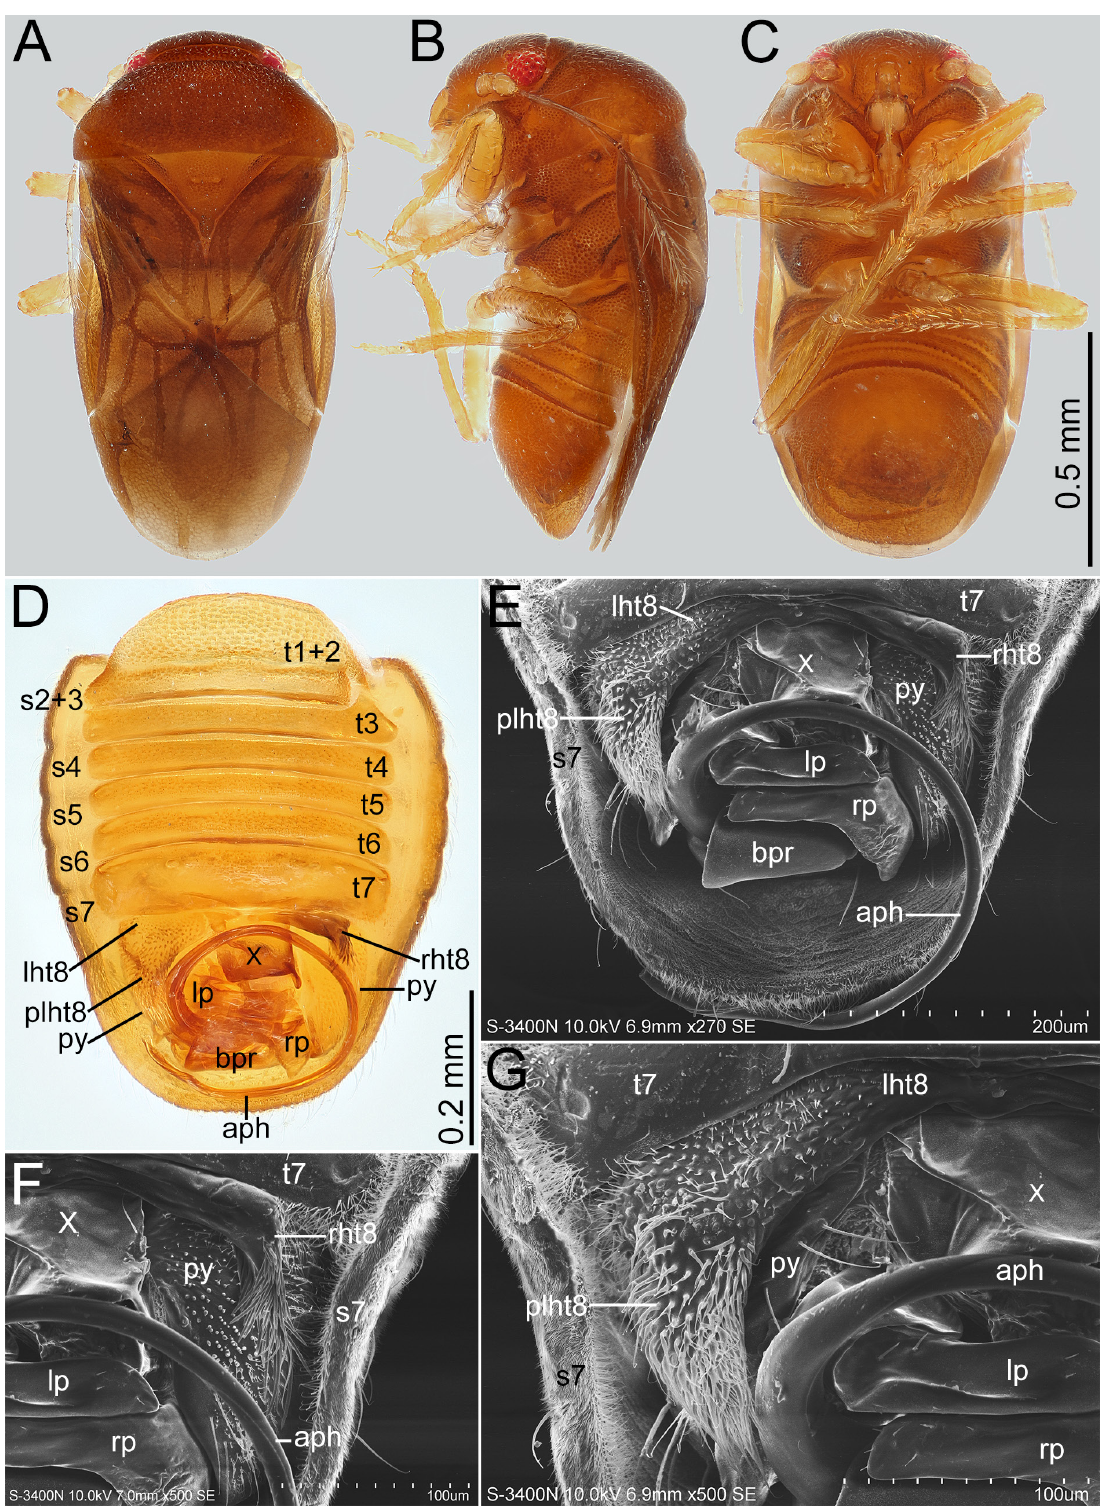
Fig. 19. Kokeshia renae sp. nov. A‒C . Habitus, holotype, ♂ (SYSBM). A . Dorsal view. B . Lateral view. C . Ventral view. D . Pregenital abdomen and genitalia, dorsal view, paratype, ♂ (SYSBM). E‒G . Scanning electron micrographs of genitalia, paratype, ♂ (SYSBM). E . Dorsal view. F . Right side, dorsal view. G . Left side, dorsal view. Abbreviations: see Material and